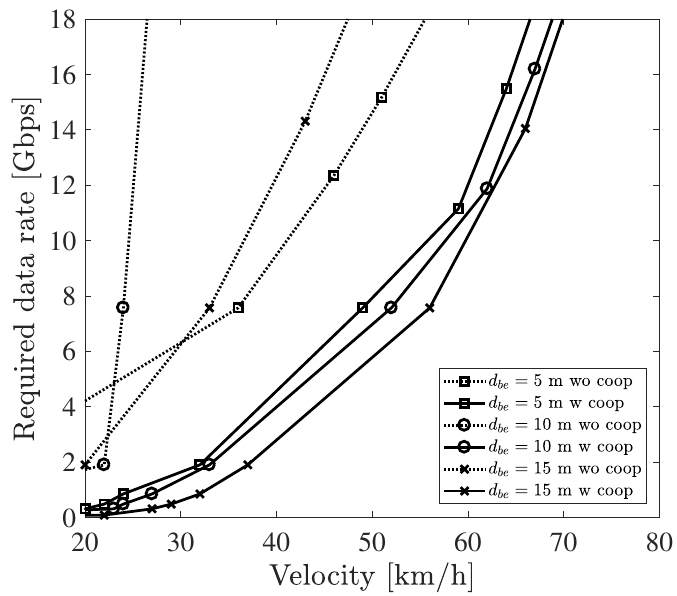
Figure 11. The required sensor data rate with the options of cooperative perception and 5 s overtaking when the distance between the ego vehicle and the blocking vehicle is 5, 10, and 15 m.